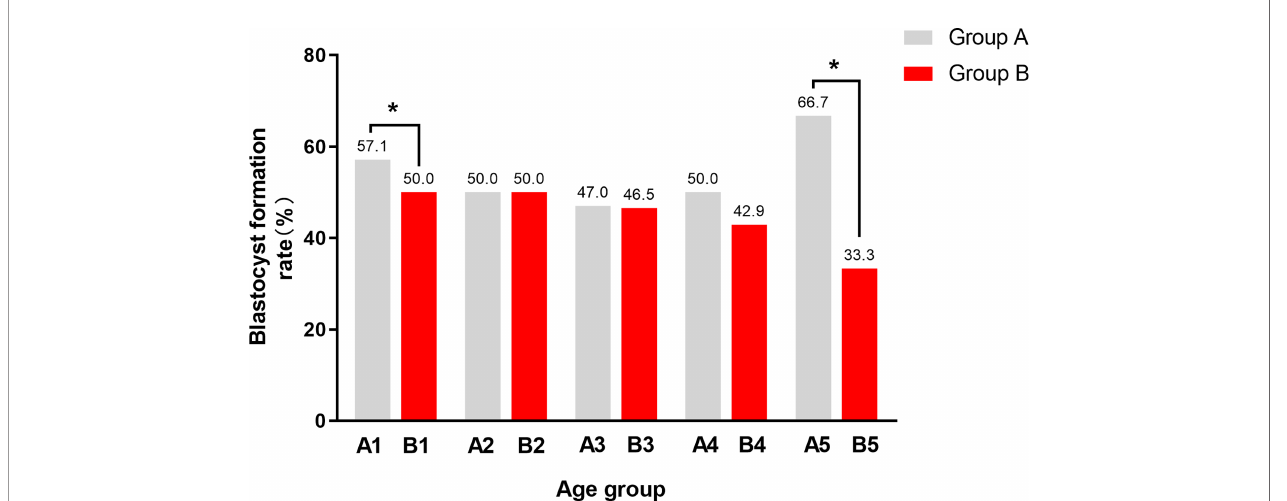
FIGURE 1 | The blastocyst formation rate between male carriers and female carriers in different age groups. Group A, couple with a male carrier; Group B, couple with a female carrier. A1, maternal age < 35y and paternal age < 30y in Group A; B1, maternal age < 35y and paternal age < 30y in Group B; A2, maternal age < 35y and paternal age between 30-34y in Group A; B2, maternal age < 35y and paternal age between 30-34y in Group B; A3, maternal age < 35y and paternal age ≥ 35y in Group A; B3, maternal age < 35y and paternal age ≥ 35y in Group B; A4, maternal age ≥ 35y and paternal age < 38y in Group A; B4, maternal age ≥ 35y and paternal age ≥ 38y in Group B; A5, maternal age ≥ 35y and paternal age ≥ 38y in Group A; B5, maternal age ≥ 35y and paternal age ≥ 38y in Group (B) The most signi fi cant difference was between A5 and B5, whose maternal age ≥ 35 and paternal age ≥ 38. In addition, there was a statistical difference between A1 and B1,whose maternal age < 35 and paternal age < 30. The blastocyst formation rate of male carriers is higher than that of female carriers in both 1 and 5 groups. *P < 0.05 was considered statistically signi fi